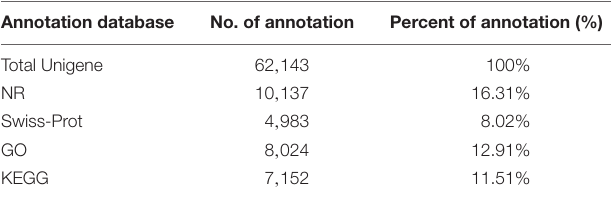
TABLE 1 | All-in-one list of